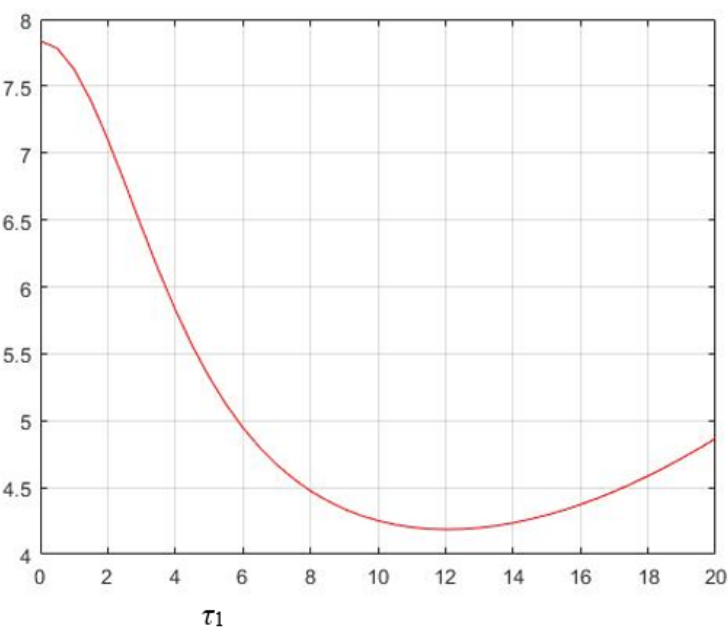
τ * 0 τ τ< < < τ 2 1 2 1 , and .